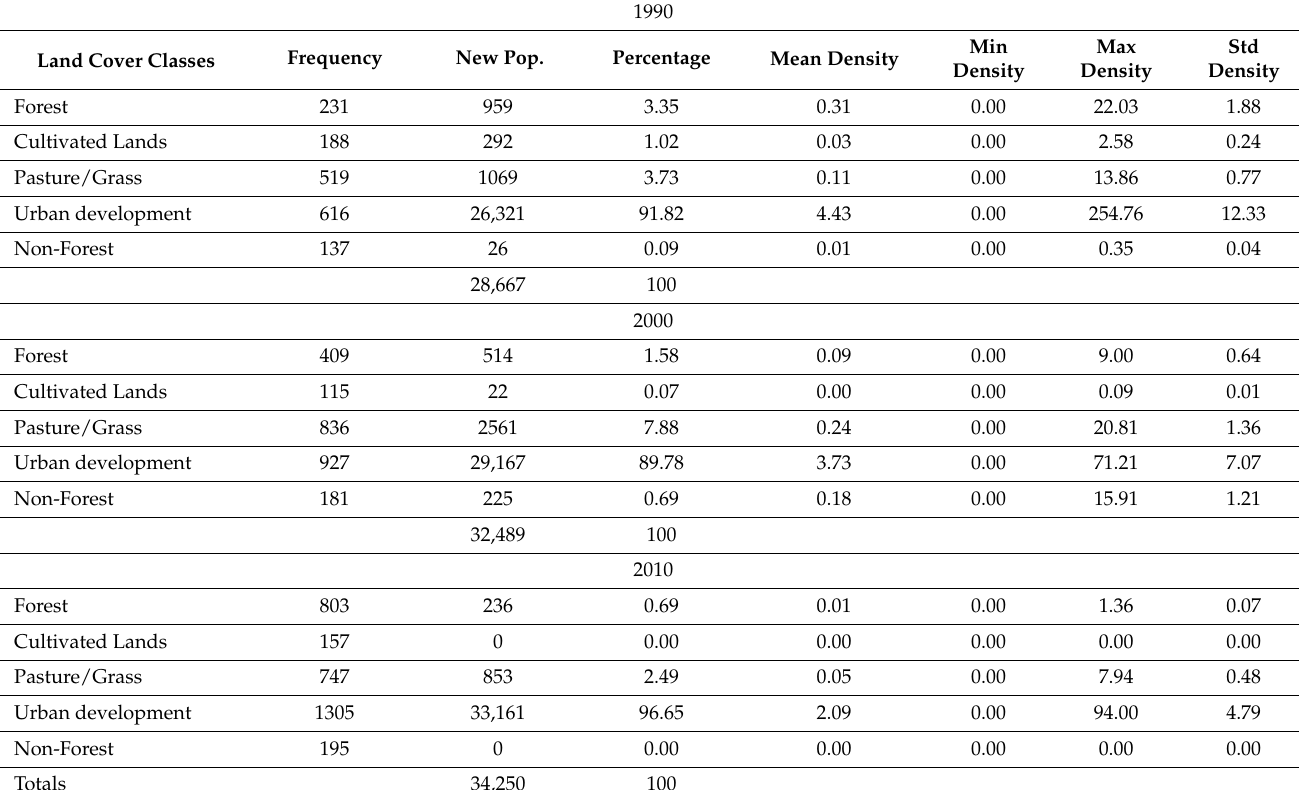
Table 3. Dasymetric mapping population statistics summary in JBNERR by census blocks level.